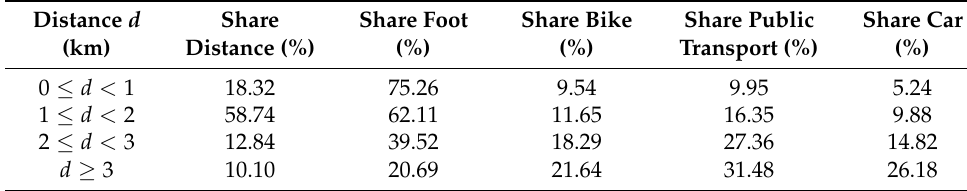
Table 1. Traffic distribution in the operational